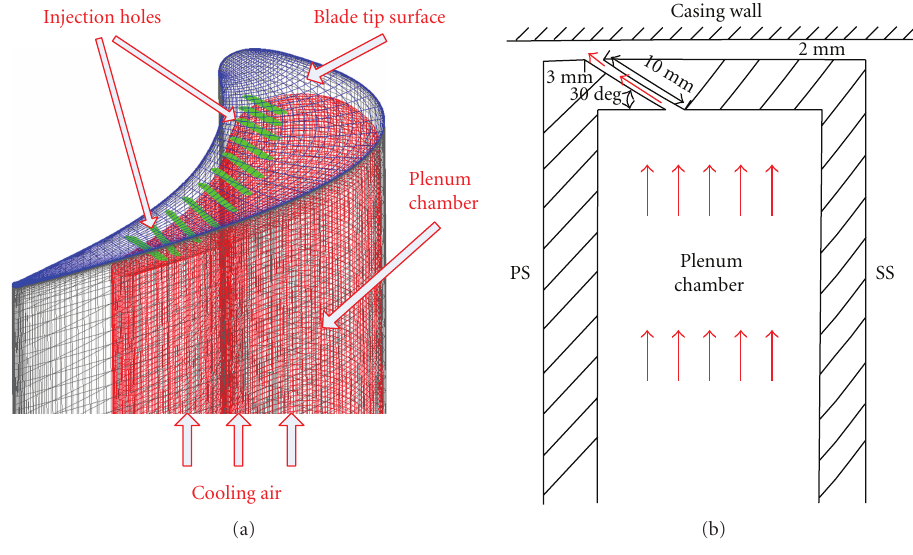
Figure 1: Schematic diagram of injection system.